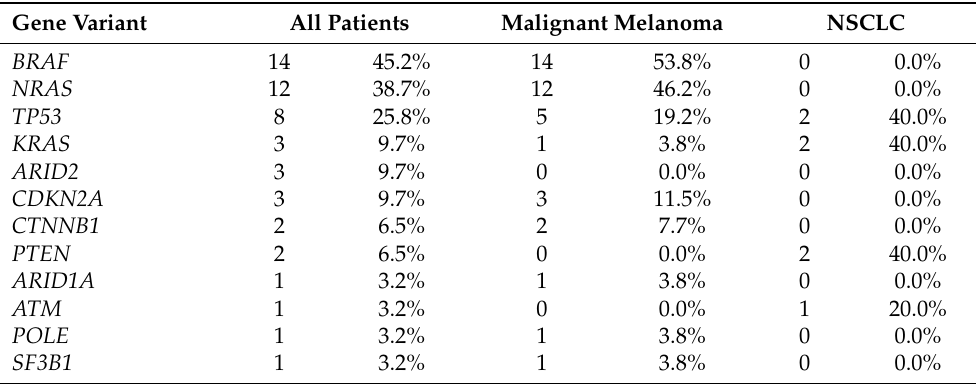
Table 2. Results of comprehensive genomic profiling and pathogenic gene